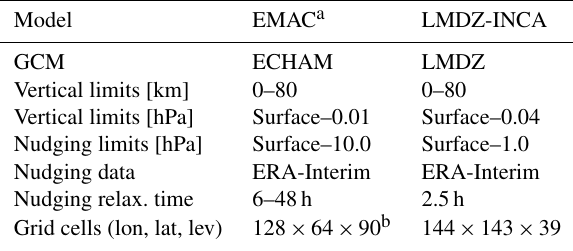
Table 1. Table stating the key properties of the model setups for EMAC and LMDZ-INCA, as applied for this